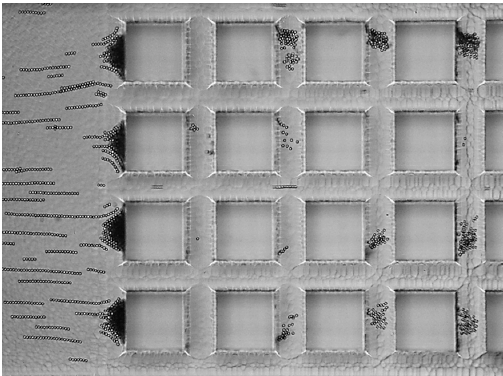
Figure 4. Image of cDEP device under operation (350 V RMS , 100 Hz, 5 μ L/h), trapping polystyrene spheres with a diameter of 3.3 μ m. Square pillars are 100 μ m by 100 μ m.